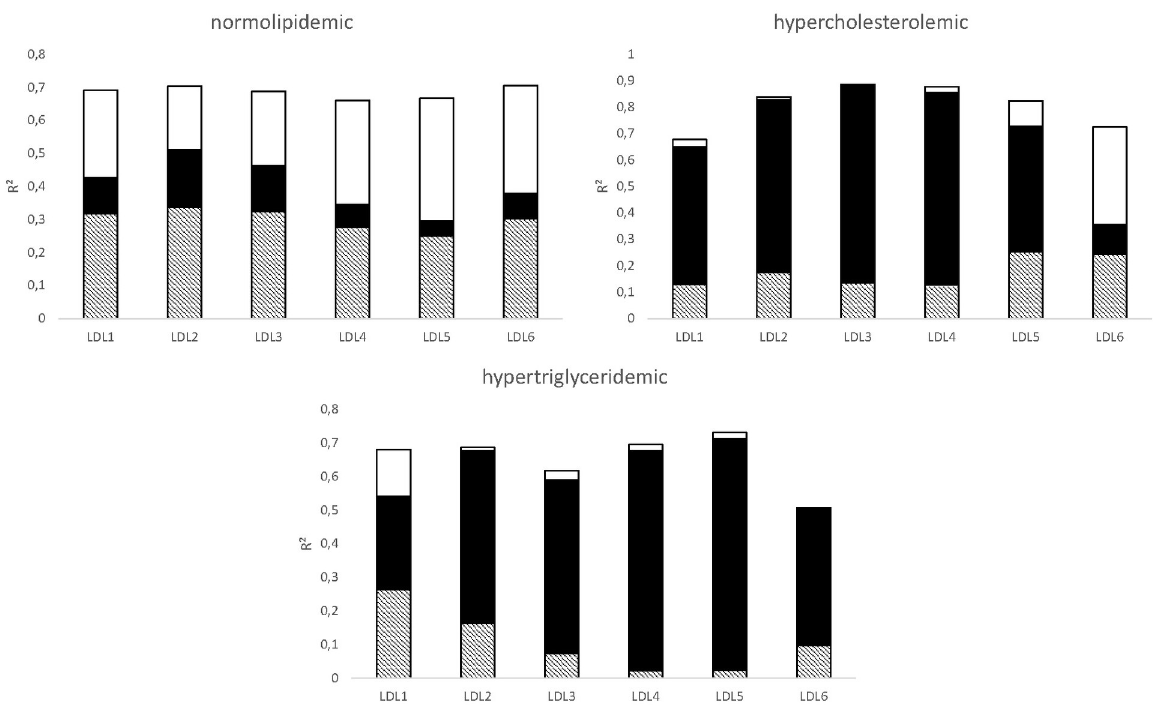
Fig 3. Estimating the influence of CETP on LDL’s lipid composition. The bar represents the coefficient of determination R 2 of a multiple linear regression model predicting LDL 1 TG (cid:0) LDL 6 TG using the two explanatory variables V 1 : IDL TG and V2: HDL 2 b TG in 3 subgroups. Let r 2 ( V 1) CE CE CE CE and r 2 ( V 2) be the coefficients of determination, if only V 1 or V 2 are used as explanatory variable in a corresponding single linear regression, respectively. Three parts contribute to R 2 : V1 without V2 (white, R 2 -r 2 ( V 2)), V2 without V1 (black, R 2 -r 2 ( V 2)), and V1 and V2 intersecting (dashed, r 2 ( V 1)+ r 2 ( V 2)-R 2 ).